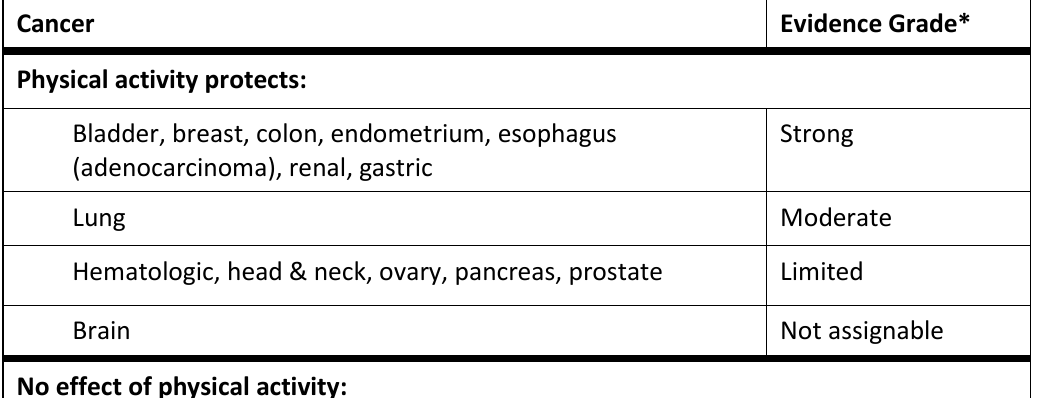
Table F4-1. Summary of Associations of Physical Activity and Sedentary Behavior with Specific Cancers, with Subcommittee-assigned Evidence